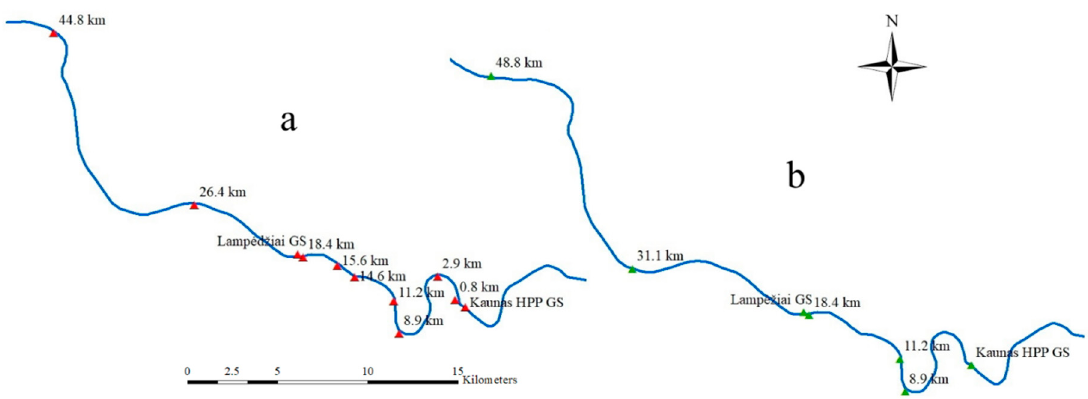
Figure 3. River stage recording sites at the Nemunas River with chainage showing permanent gauging stations (GS) and temporary measurement sites (operating in 2015 ( a ) and 2016 ( b )). Temporary measurement sites with data loggers recorded the river stage at 10-min time spans